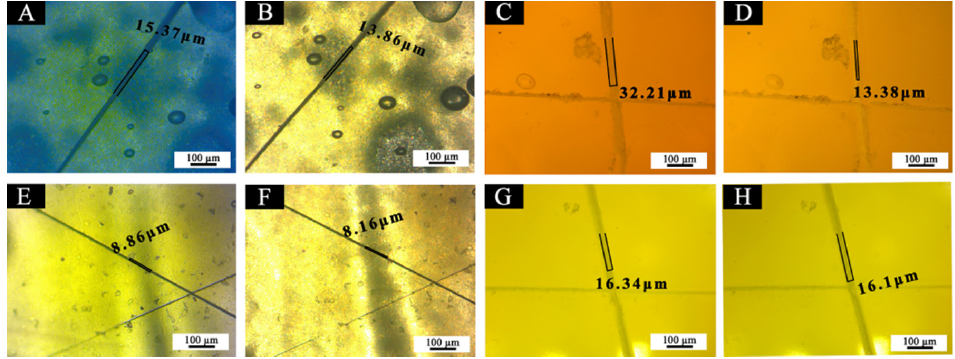
Figure 21. OM of coating films: before self-repairing ( A ) 5#, ( C ) 7#, ( E ) 11#, ( G ) 12#, after self-repairing